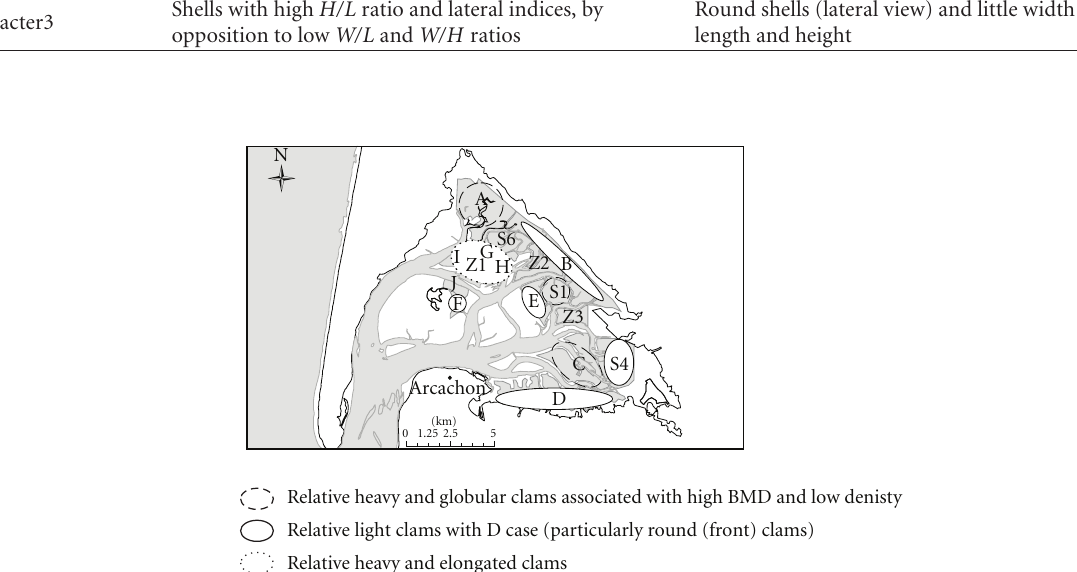
Figure 3: Spatial vizualisation of the allometry patterns related to density and disease.